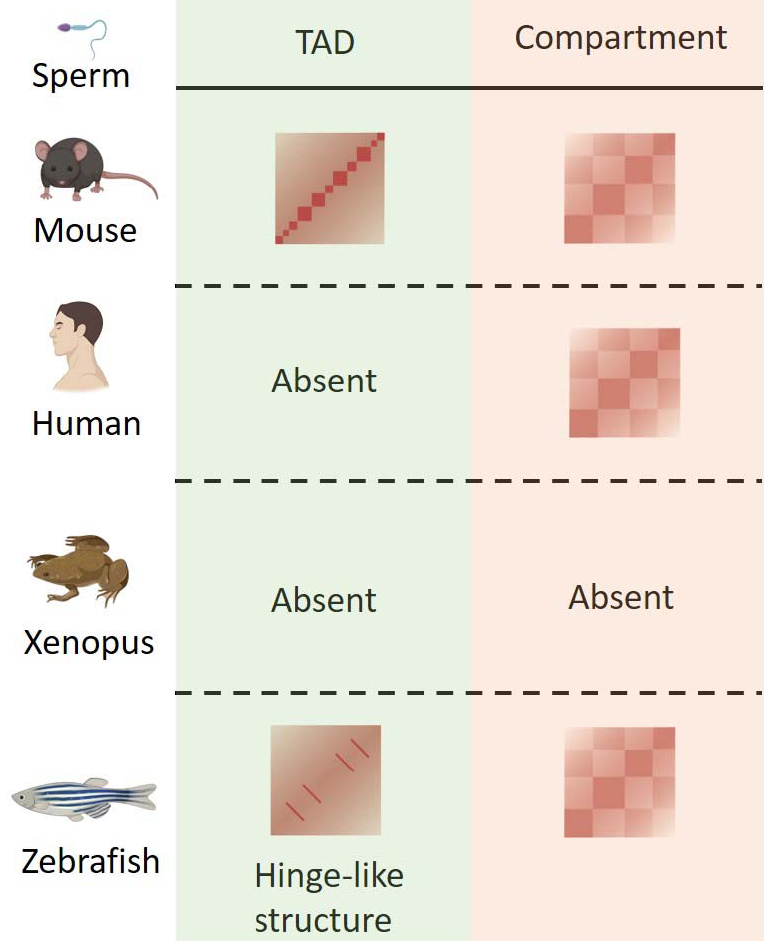
Figure 1. TADs and compartment structures in sperms of different species. TADs are present in mouse and zebrafish sperm, but are absent in human and xenopus sperm. Mouse sperm has canonical TAD structures. Zebrafish sperm shows unique “hinge-like” TAD structures. As for A/B compartments, clear A/B compartment structures can be detected in mouse, human and zebrafish sperm but not in xenopus sperm.